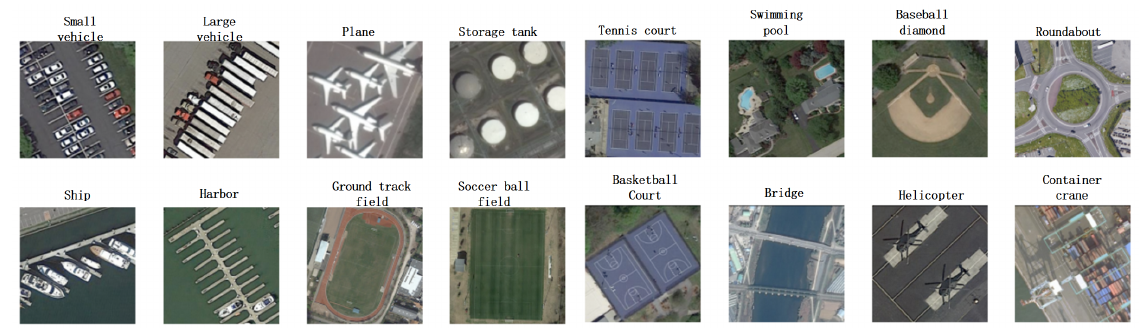
Figure 6. DOTA Dataset Category Display.